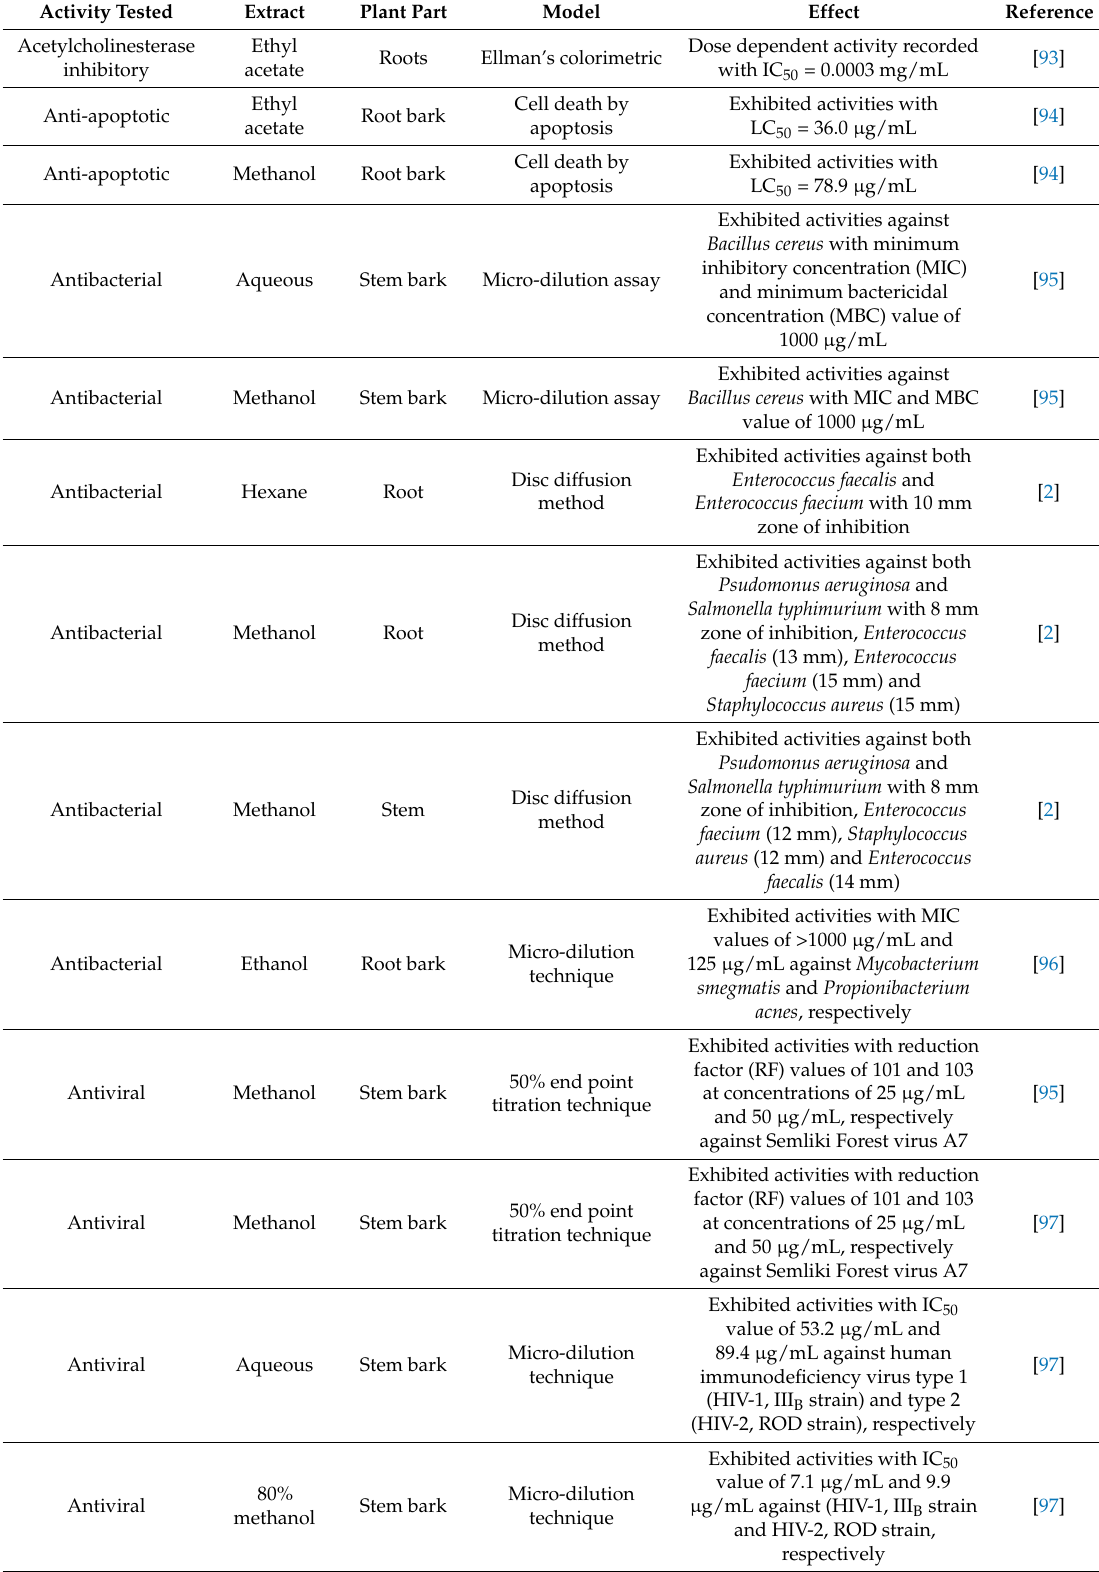
Table 4. Summary of pharmacological activities of Lannea schweinfurthii